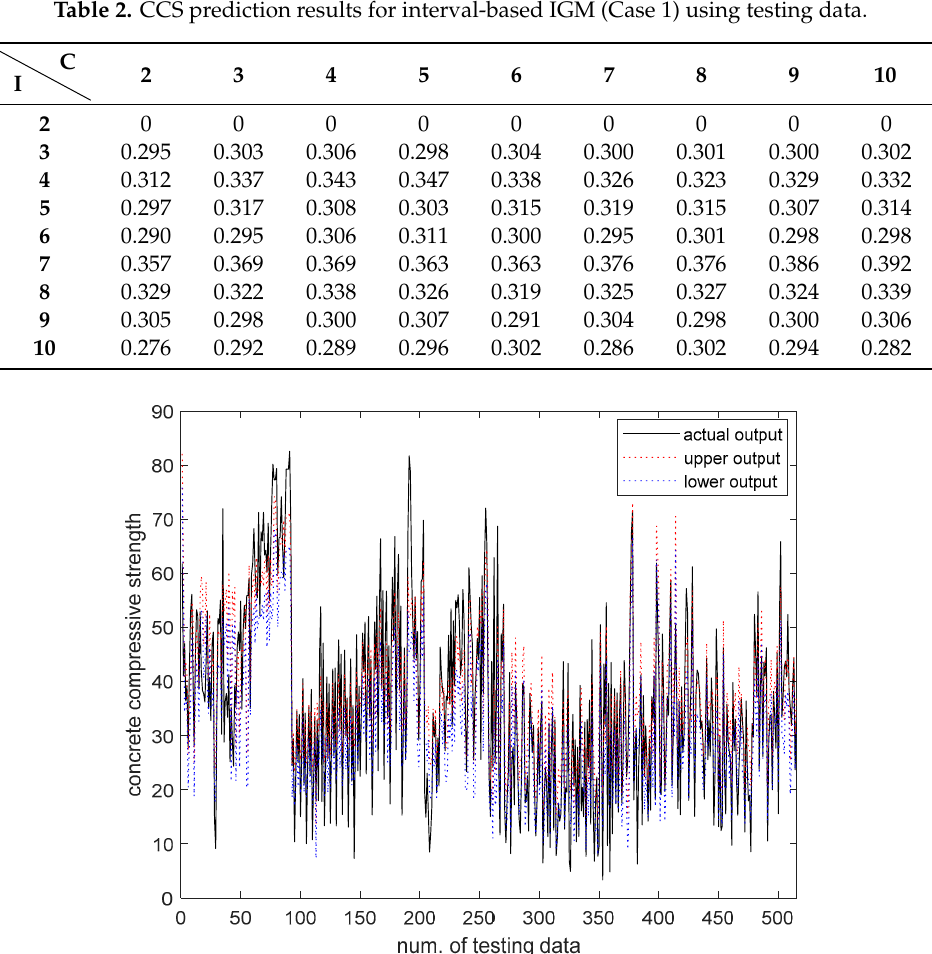
Figure 10. Prediction results for interval-based IGM (Case 1).